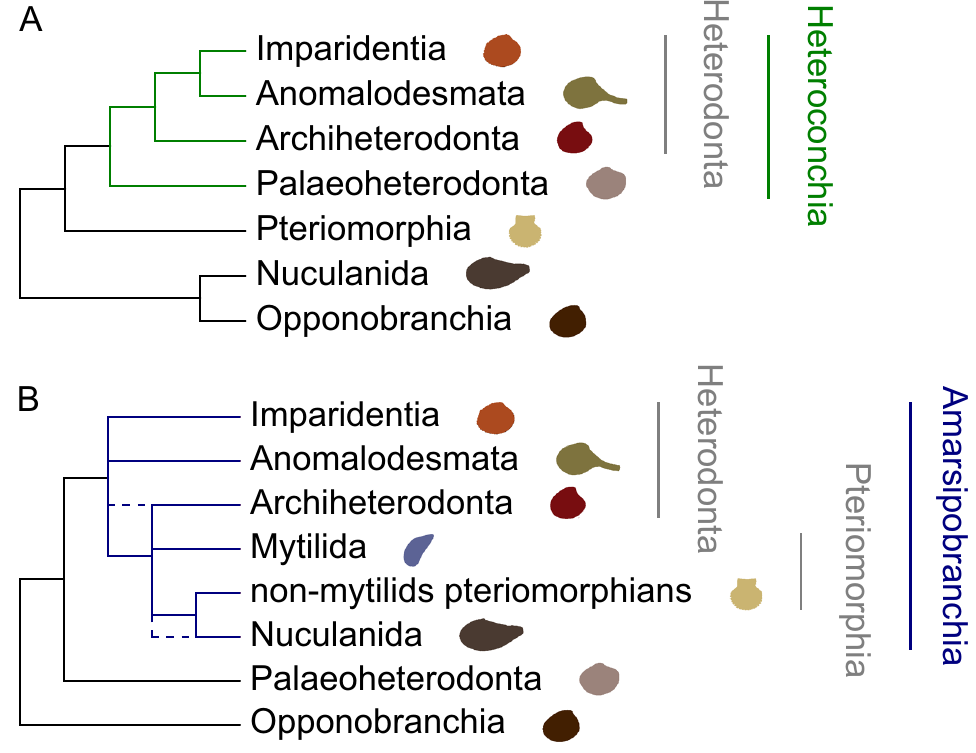
Figure 1. The two main alternative resolutions of the Bivalvia phylogenetic tree. ( A ) The Heteroconchia hypothesis. ( B ) The Amarsipobranchia